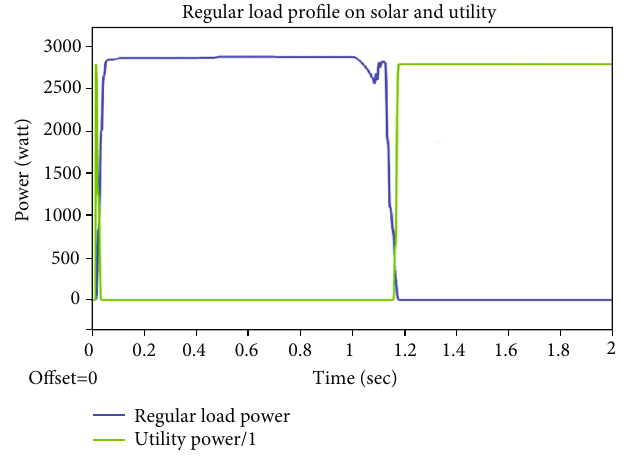
Figure 36: Regular load pro fi le of house 4.